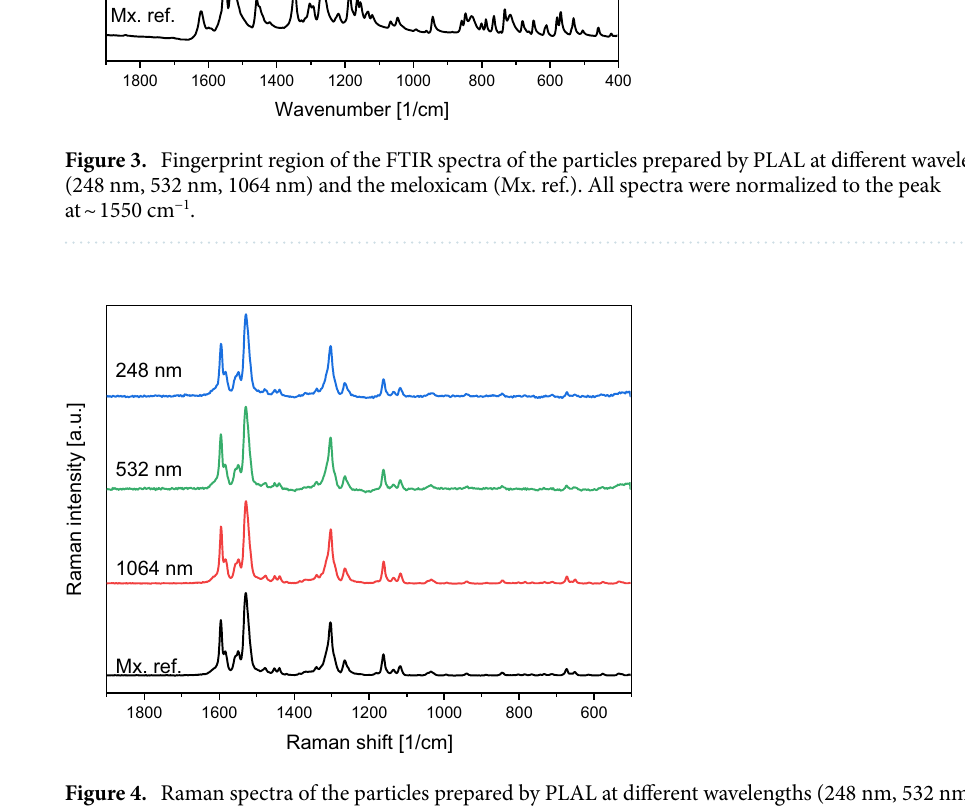
Figure 4. Raman spectra of the particles prepared by PLAL at different wavelengths (248 nm, 532 nm, 1064 nm) and the meloxicam (Mx. ref.). All spectra were normalized to the peak at ~ 1530 cm −1